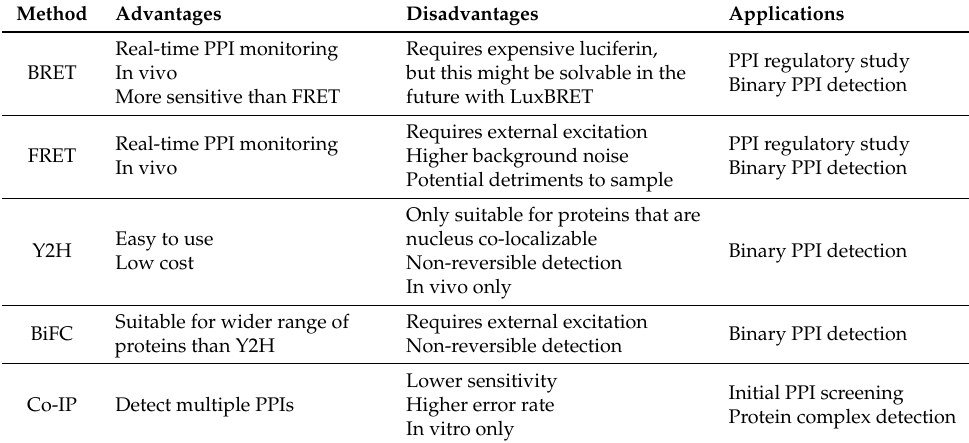
Table 1. Comparisons between Bioluminescence Resonance Energy Transfer (BRET), Fluorescence Resonance Energy Transfer (FRET), Yeast Two-Hybrid (Y2H), Bimolecular Fluorescence Complementation (BiFC), and Co-Immunoprecipitation